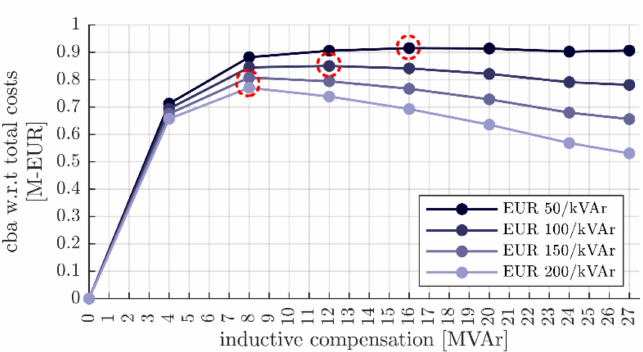
Figure 11. Sensitivity of optimal reactor size with respect to investment